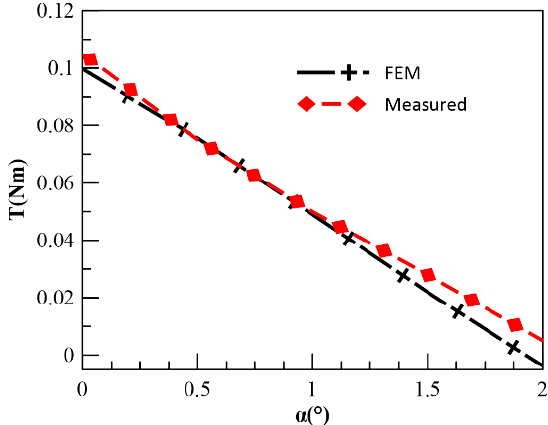
Figure 24. The electromagnetic torque angle characteristic curve of CPMLTM.